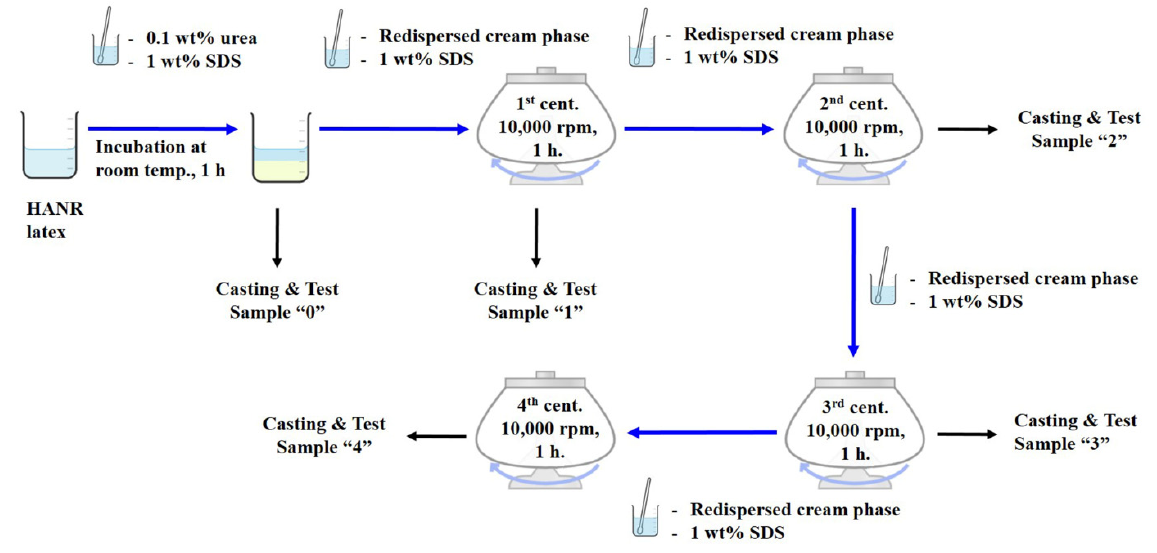
Figure 1. Preparation of DPNR with multiple washing/centrifugation cycles at 12,320 g-forces.